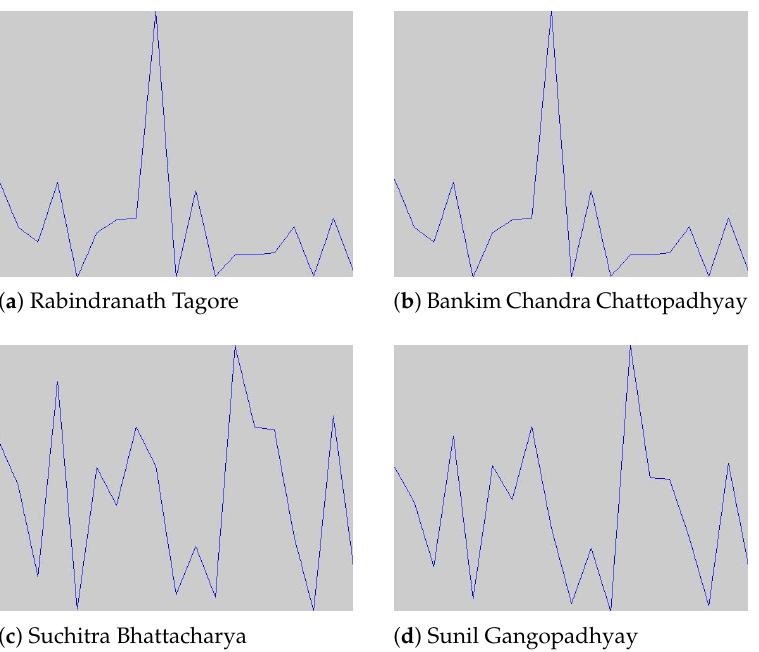
Figure 6. The feature visualizations of one document by four authors using line charts. The x-axis represents the 17 features considered in the experiment. The y-axis represents the feature values obtained for each feature. The line chart follows the default color for the feature values.